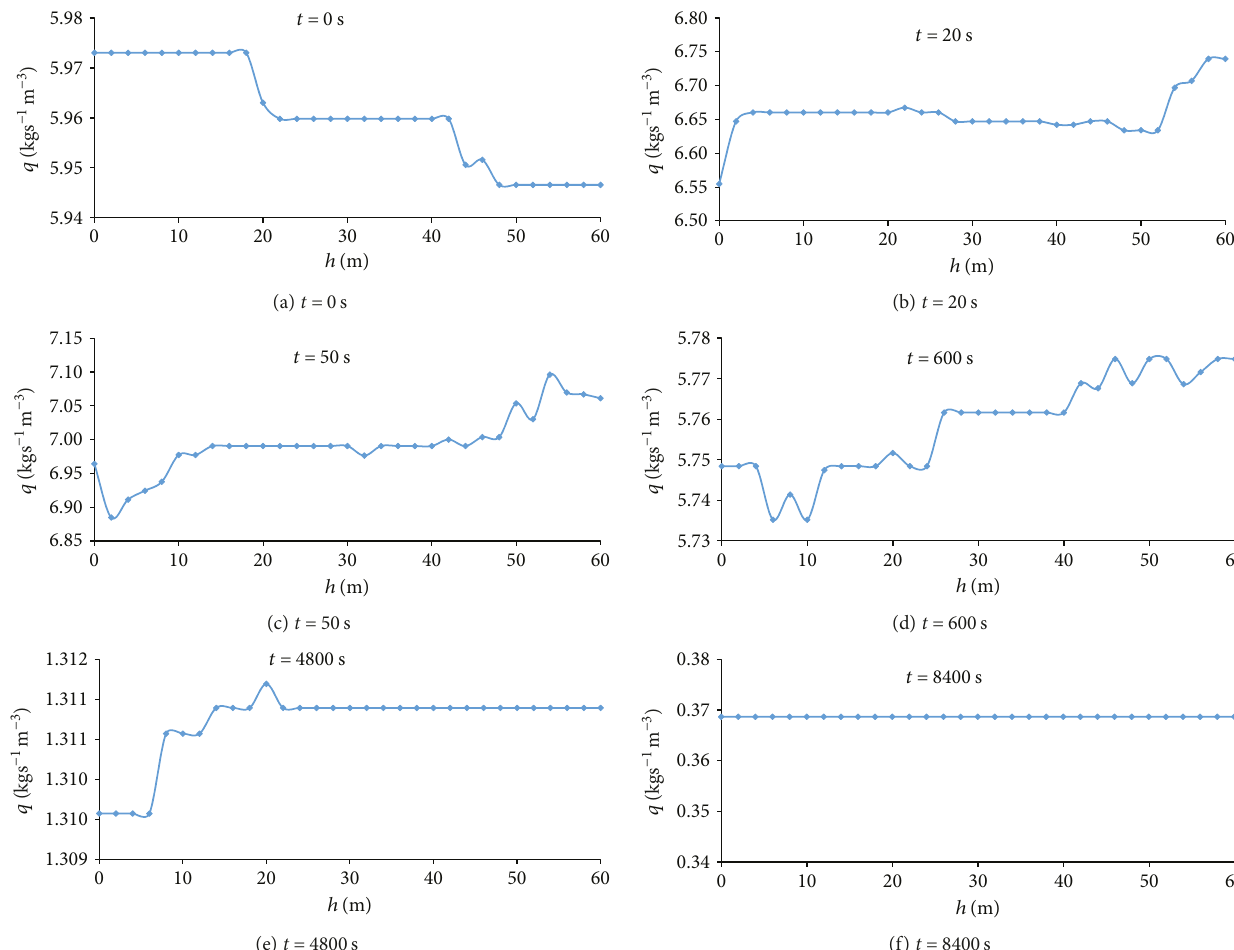
Figure 13: Spatial distribution of mass-loss rate at di ff erent time points.